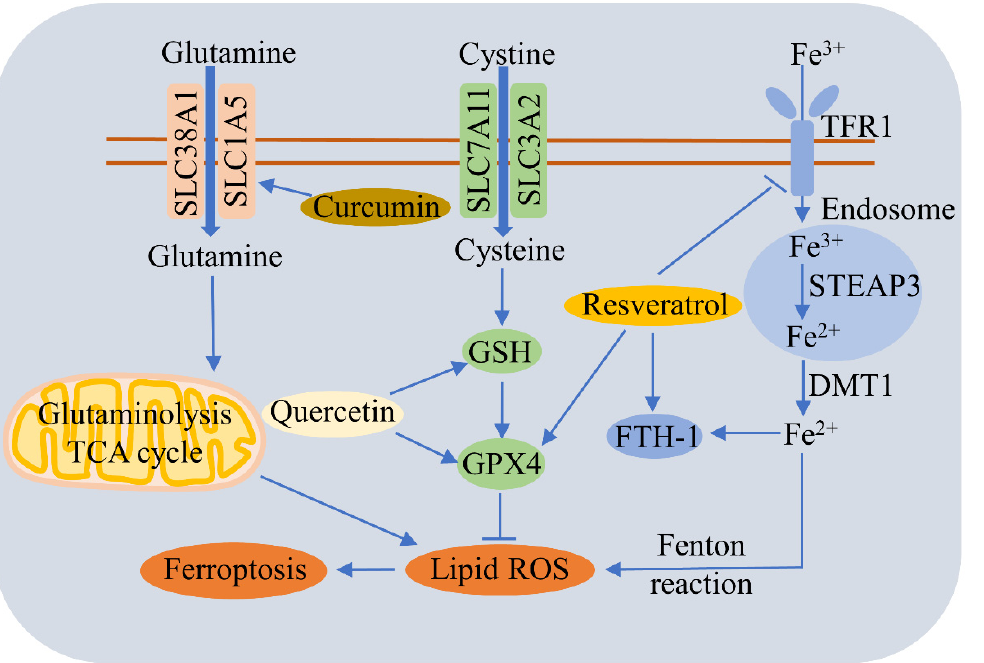
Figure 4. Regulatory effects of foodborne active ingredients on ferroptosis. This schematic diagram shows the regulation pathways of ferroptosis by polyphenols such as quercetin, curcumin, and resveratrol. Curcumin triggers ferroptosis by promoting SLC1A5-mediated glutamine uptake. Quercetin alleviates ferroptosis by upregulating GSH and GPX4. Resveratrol reduces ferroptosis by decreasing TfR1 expression and increasing the expressions of FTH1 and GPX4.